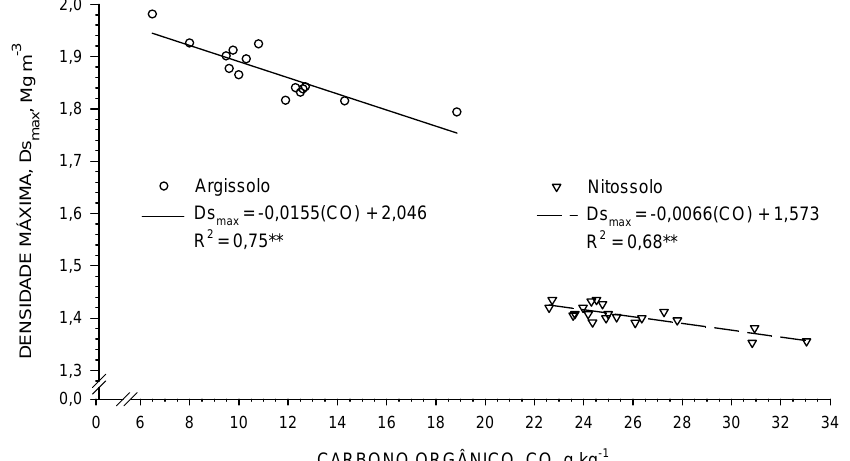
CARBONO ORGÂNICO, CO, g kg